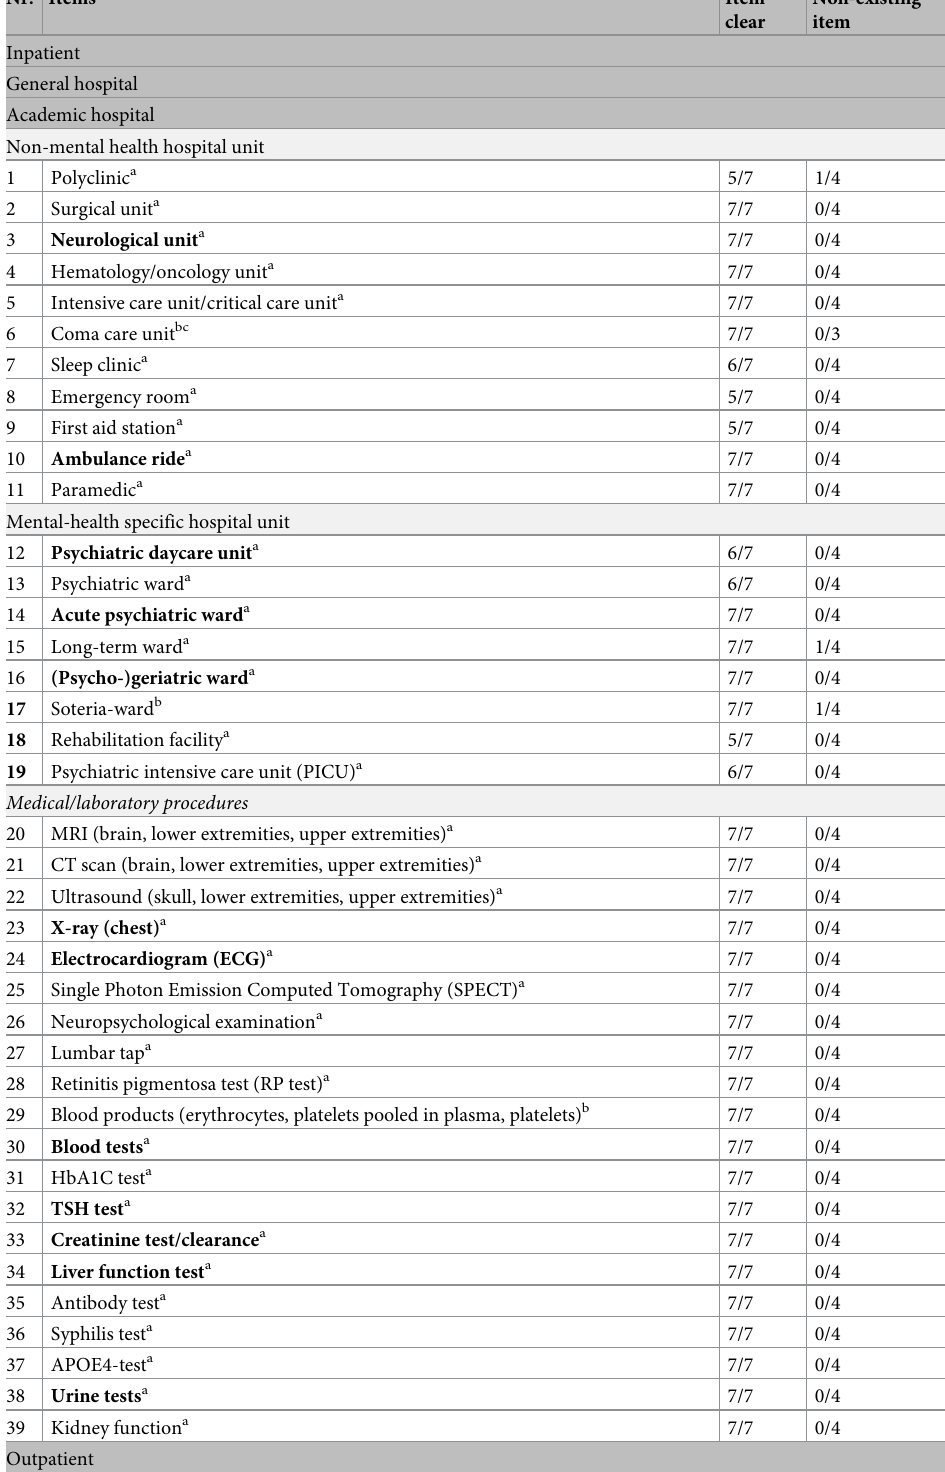
Table 2. Characteristics of items in the health and social care (HCSC) sectors list, Austrian survey. Nr. Items Item